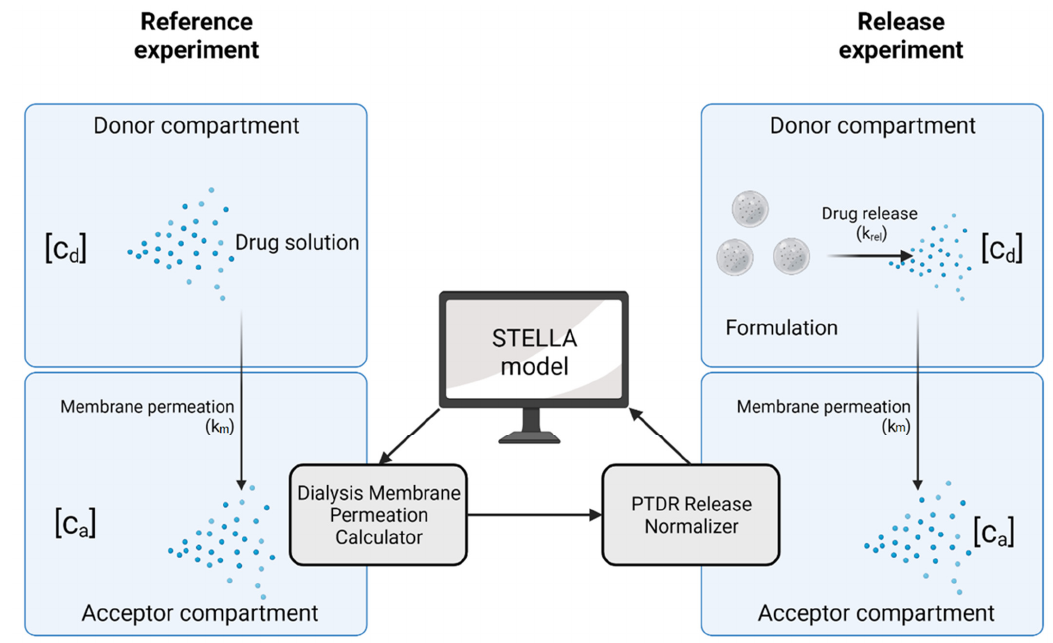
Figure 2. Kinetic processes involved in dialysis. The membrane permeation rate ( k m ) is determined in a reference experiment using a drug solution. This membrane permeation rate is later applied in the normalization of the release profile. In this illustration [c d ] represents the drug concentration in the donor compartment and [c a ] the drug concentration in the acceptor compartment. Created with BioRender.com.